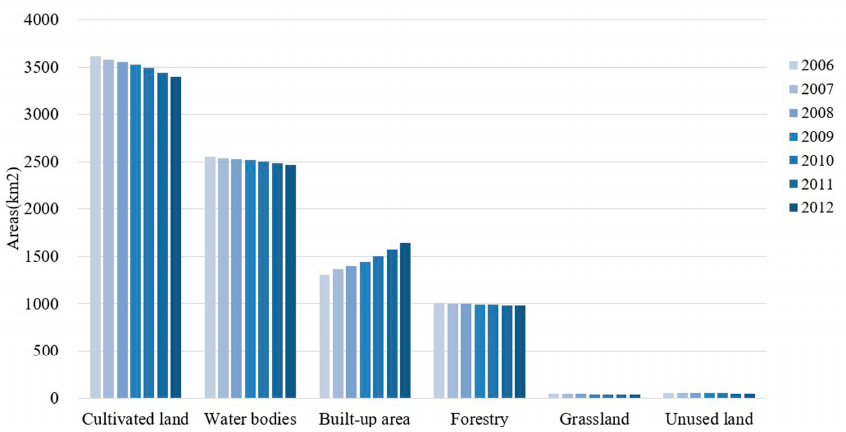
Figure 4. Structure of land use in Wuhan from 2006 to 2012.